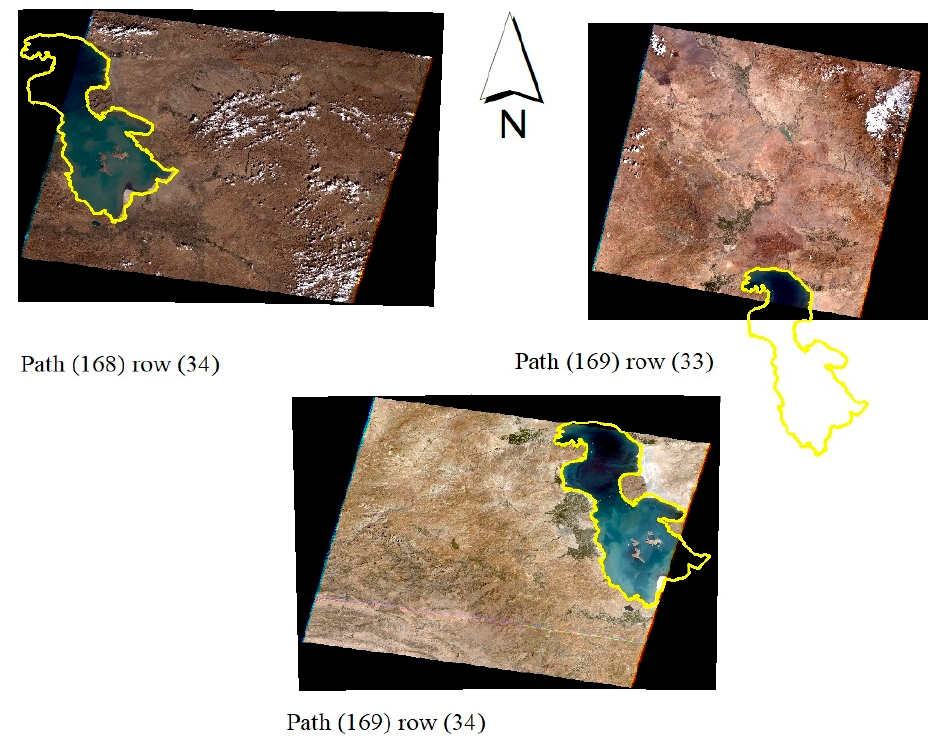
Figure 2. Geographical position of the satellite imageries used for the study area.